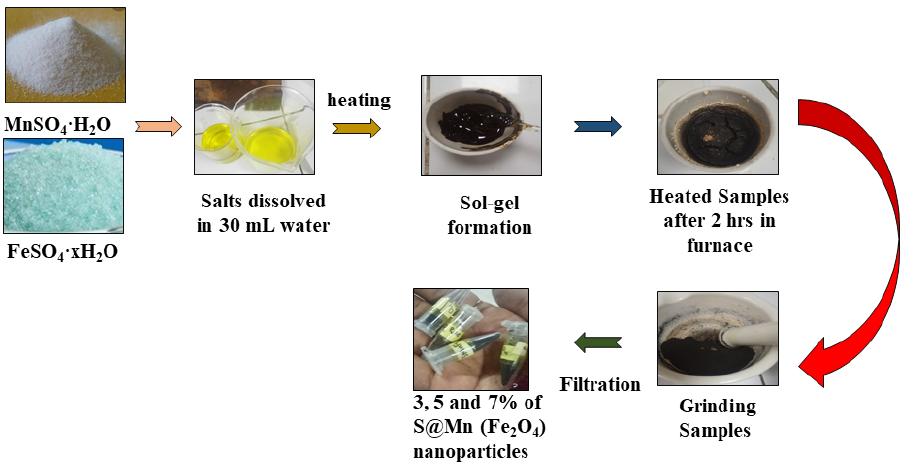
Figure 1. Synthesis of sulfur-doped manganese metal ferrites nanoparticles.